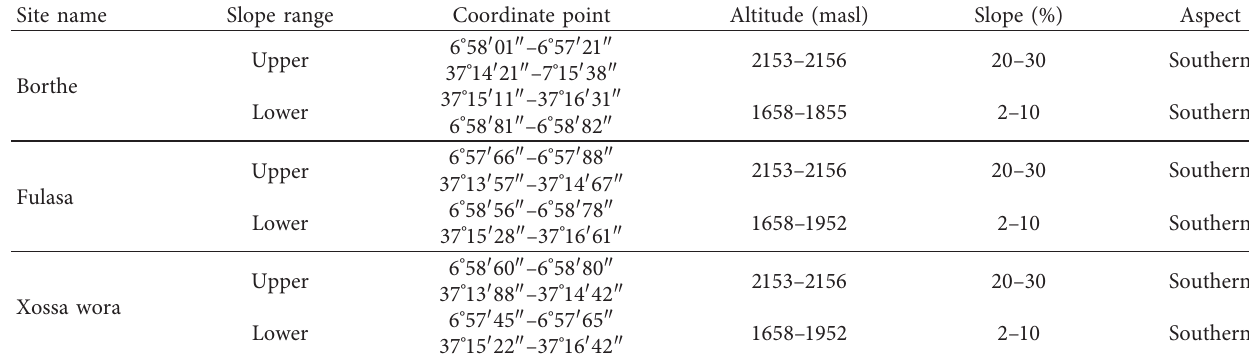
Table 1: Sample site